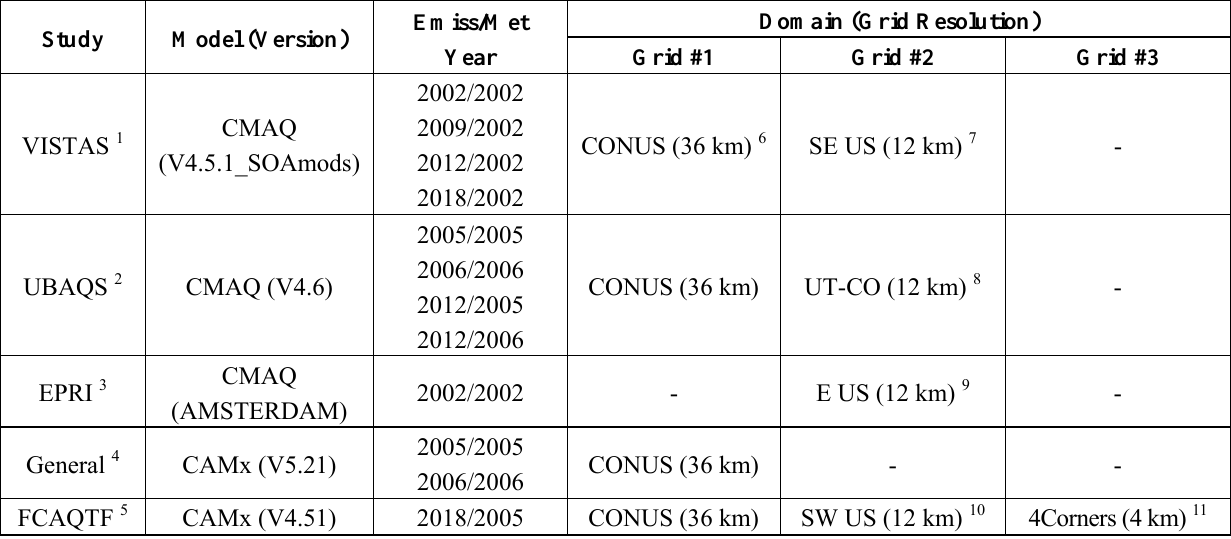
Table 1. Annual chemical transport model datasets compiled and used for this study.